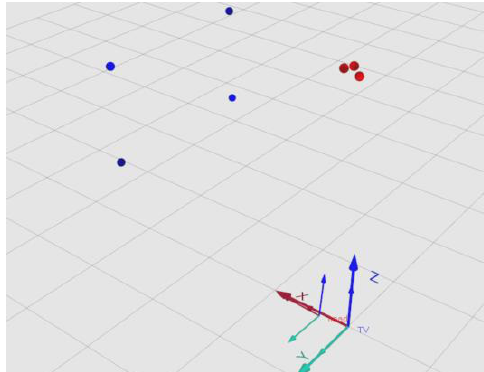
Figure 6. Qualisys Track Manager displays tracking of two rigid bodies (TV screen in blue on the left and head in red on the